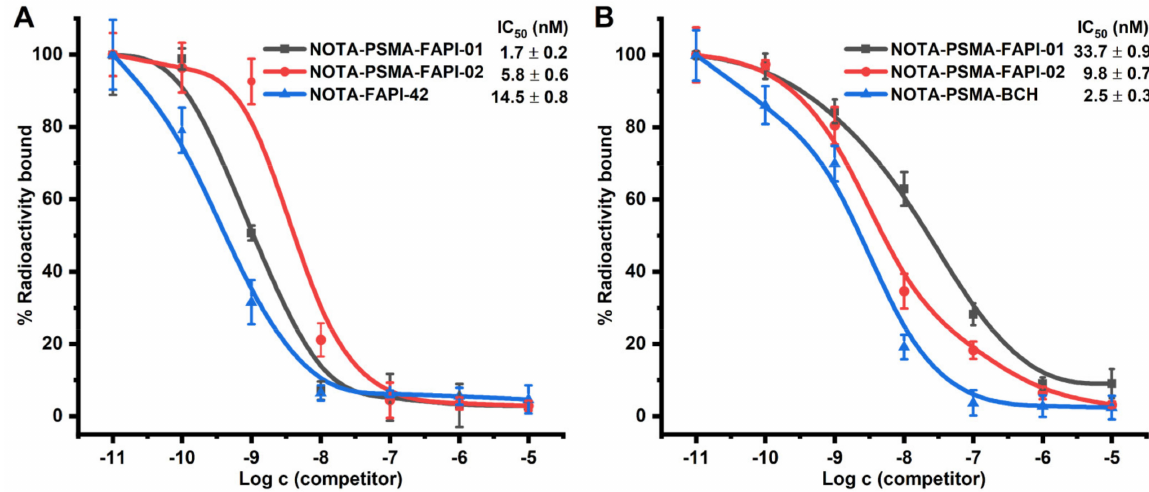
Figure 3. ( A ) Competitive binding of the heterodimers NOTA-PSMA-FAPI-01 and NOTA-PSMA- FAPI-02 and the corresponding monomer NOTA-FAPI-42 to FAP on A549-FAP cells ( n = 6). ( B ) Competitive binding of the heterodimers NOTA-PSMA-FAPI-01 and NOTA-PSMA-FAPI-02 and the corresponding monomer NOTA-PSMA-BCH to PSMA on 22Rv1 cells ( n =